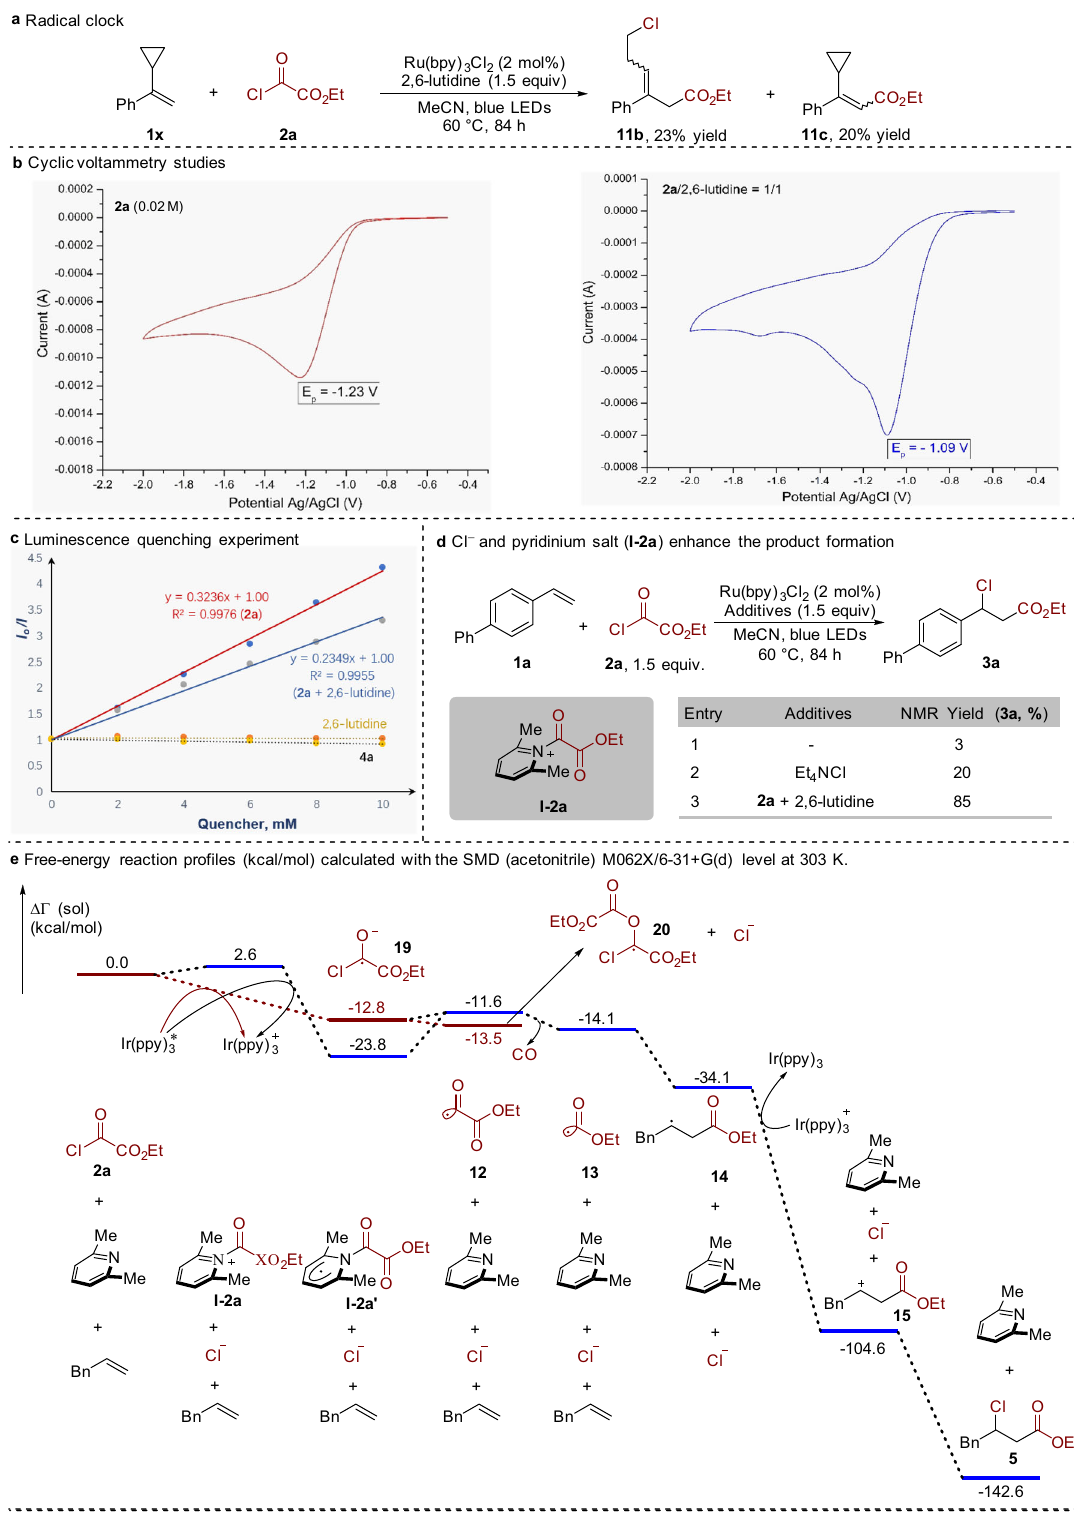
Fig. 8 Mechanistic studies. a Radical clock experiment. b Cyclic voltammetric studies. c Luminescence quenching experiment. d Cl − and pyridinium salt ( I-2a ) enhance the product formation. e Free-energy reaction pro fi les (kcal mol − 1 ) calculated with the SMD (acetonitrile) M062X/6-31 + G(d) level at 303